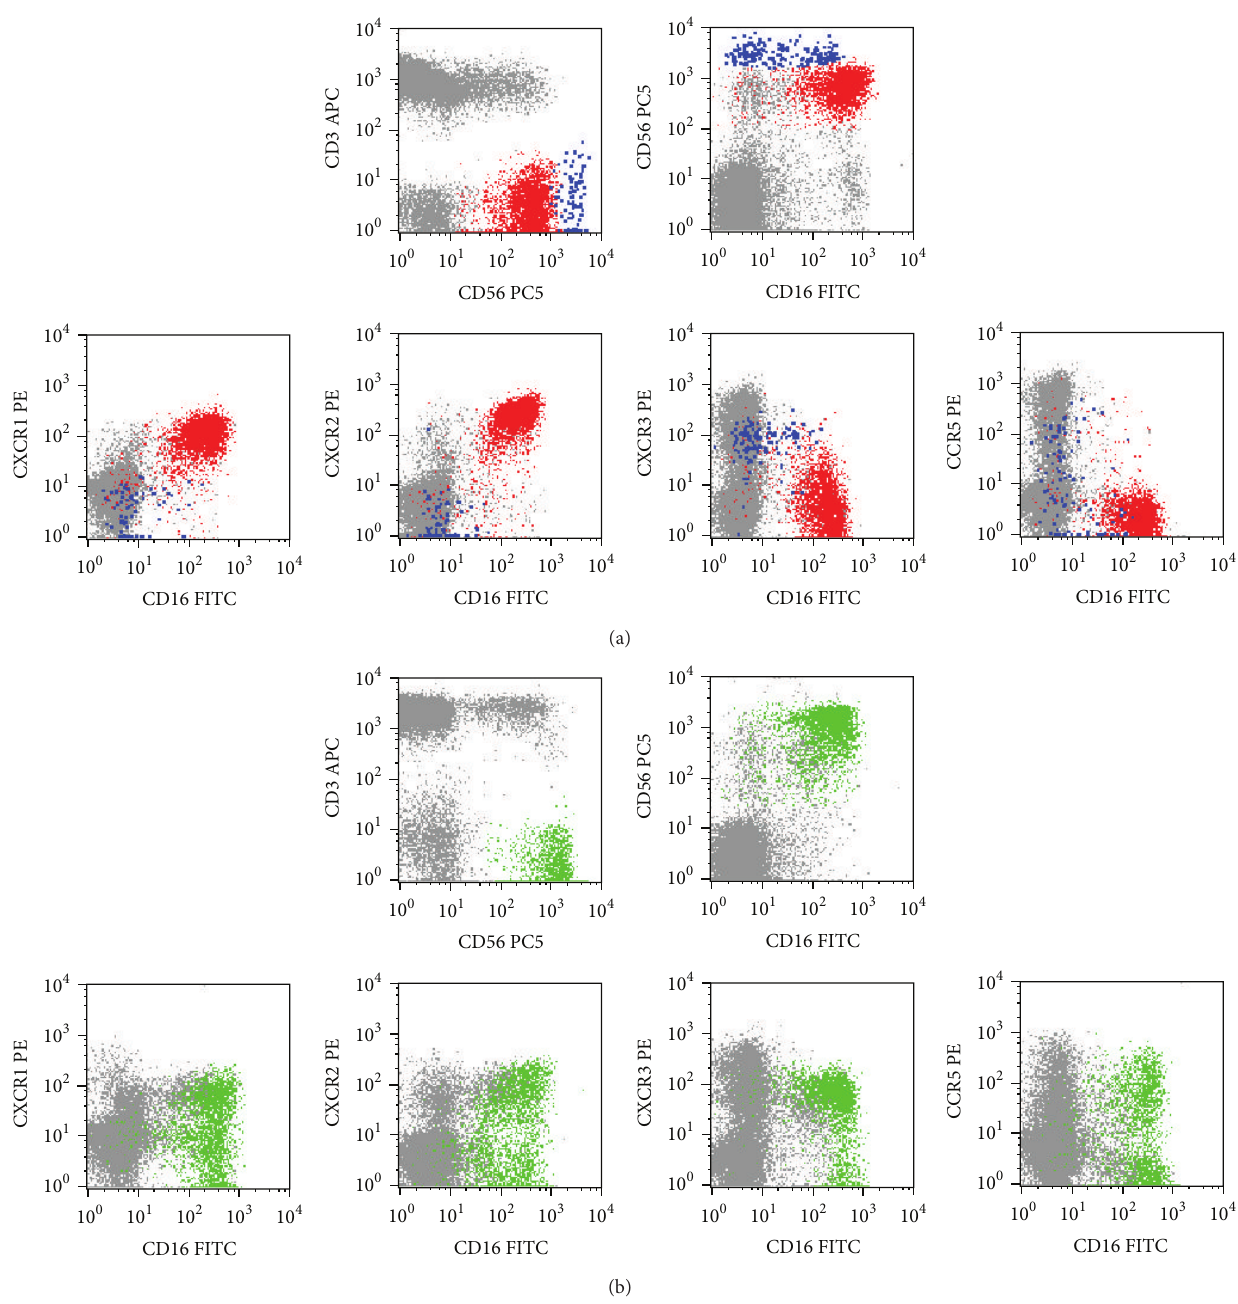
Figure 3: Illustrative dot plots showing the expression of the CXCR1, CXCR2, CXCR3, and CCR5 chemokine receptors (CKR) in normal peripheral blood (PB) (a), where only CD 56 + low (red dots) and CD 56 + high (blue dots) are observed, and in the PB of a patient with a chronic lymphoproliferative disorder of NK-cells (CLPD-NK) (b), exhibiting a transitional CD 56 + int phenotype (green dots); other lymphocytes are shown in gray. In order to obtain the dot plots showed in this figure, the PB cells were stained with APC-conjugated anti-CD3, PC5-conjugated anti-CD56,PE-conjugatedanti-CKR(CXCR1,CXCR2,CXCR3,orCCR5),andFITC-conjugatedanti-CD16monoclonalantibodies.Asshown in (a), in the normal PB most CD 56 + low NK-cells are CXCR1 + and CXCR2 + , whereas only a very small fraction of cells stains positively for CXCR3 and/or CCR5; in contrast, most CD 56 + high NK-cells are CXCR3 + whereas CCR5 is expressed in only a fraction and CXCR1 and CXCR2 are virtually negative. As it can be seen in (b), the expanded NK-cells from this patient, which have relatively high levels of CD56 expression, are CD16 + and they express the CXCR1, CXCR2, CXCR3, and CCR5 molecules in a considerable fraction of